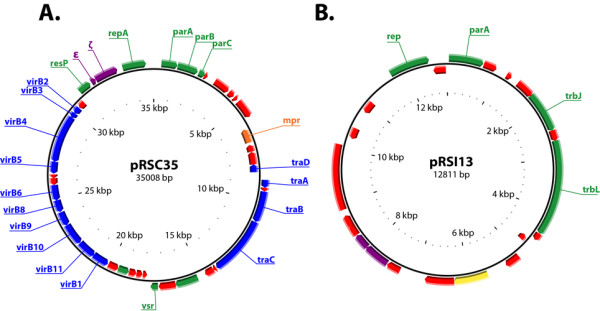
Circular representation of plasmids pRSC35 and pRSI13. A: pRSC35, B: pRSI13; in blue: Type IV Secretion System; in green: proteins involved in DNA metabolism; in purple: toxin/antitoxin systems; in red: proteins of unknown function; in orange: the metalloprotease gene of pRSC35.